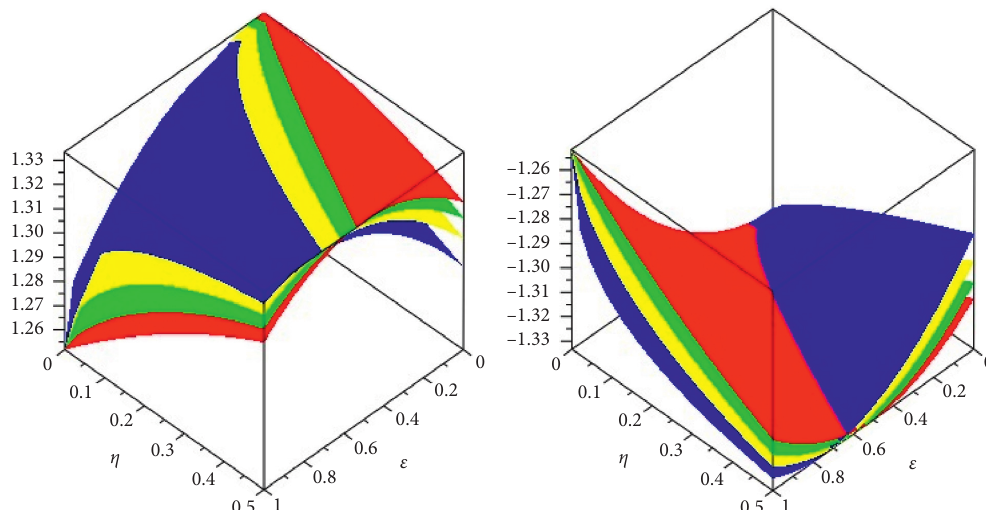
Figure 2: Various factional order of the upper and lower fuzzy figure of analytical solution of example